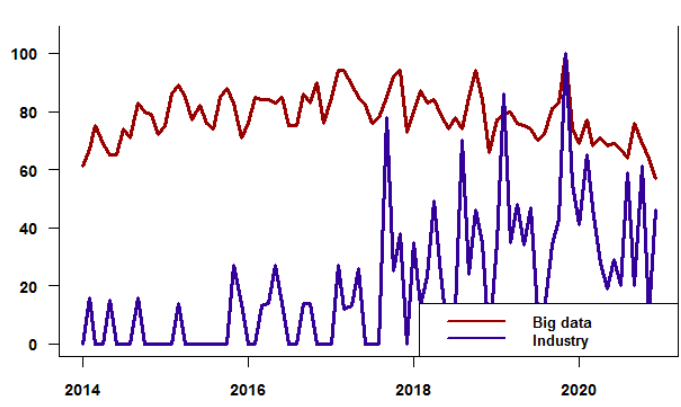
Figure 10. Big Data and SDG 9 global Google trends since